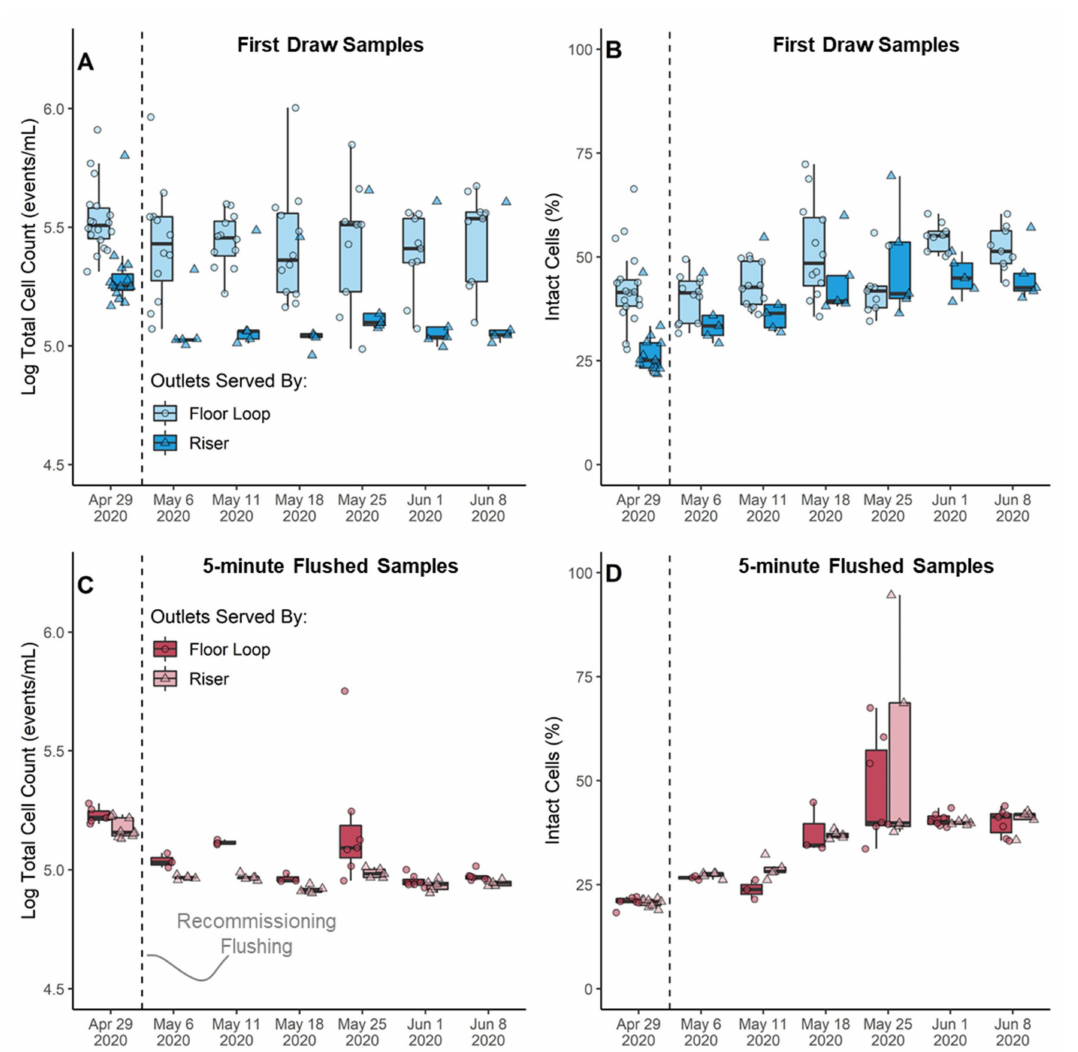
Figure 4. Total cell counts in ( A ) first draw and ( C ) 5-min flushed samples as measured by flow cytometry in events/mL. Percent of intact cells in ( B ) first draw and ( D ) 5-min flushed samples calculated by dividing intact cells by total cells in each sample. Boxplot bodies reflect the 25th, 50th, and 75th percentile; whiskers represent 1.5 times the interquartile range. Raw data is overlaid onto the boxplots. ◦ indicates samples collected from passive floor loops (laboratory outlets); ∆ indicates samples collected from hot water risers (outlets in lavatories and